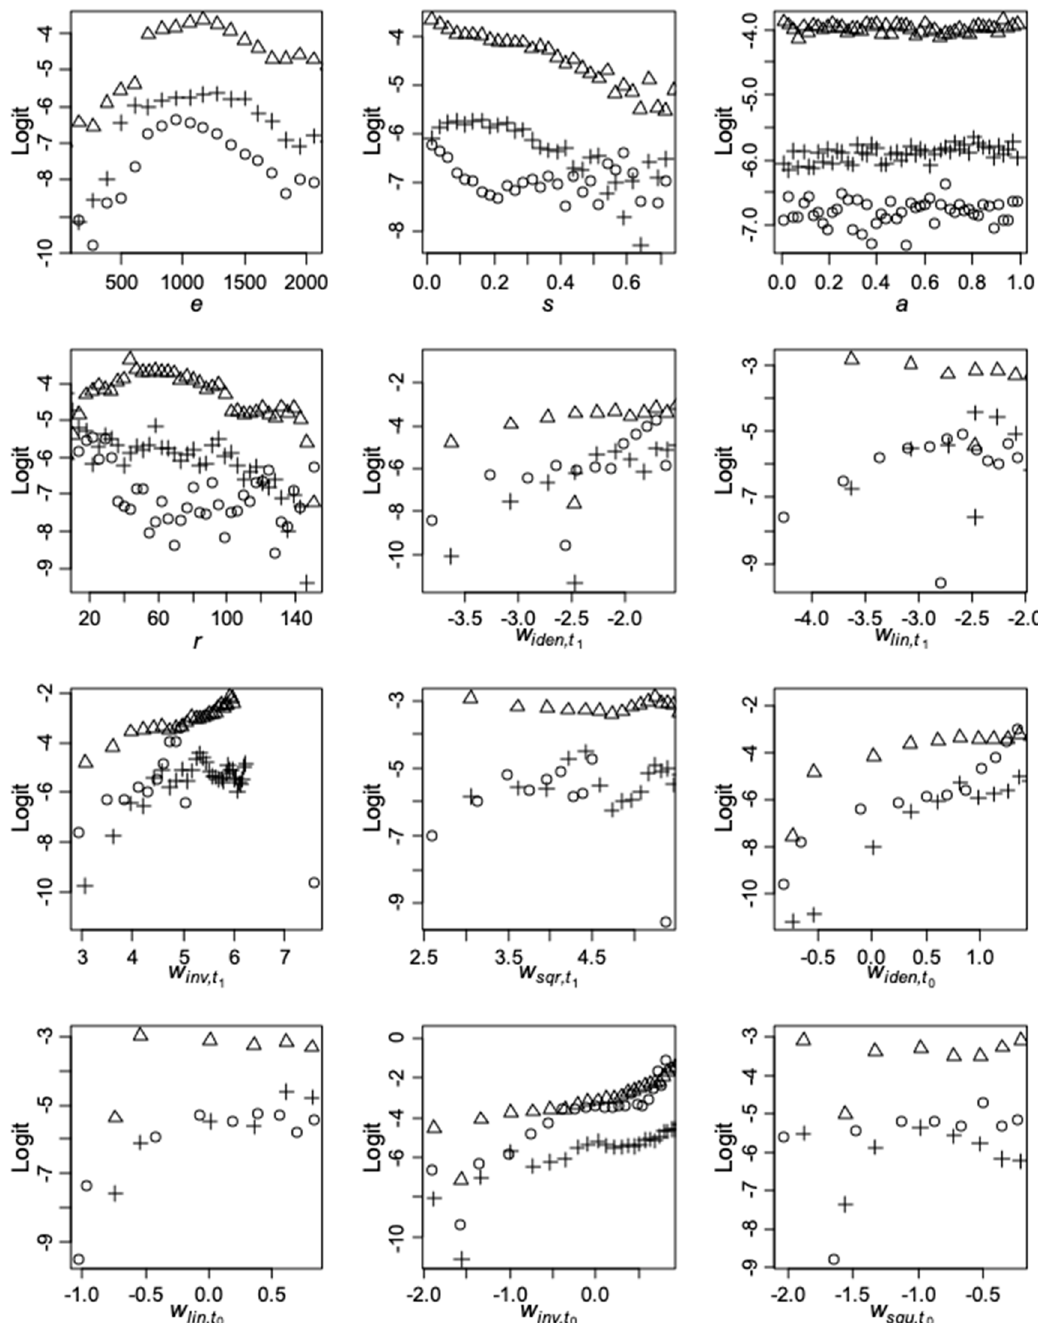
Figure A5. Plots of average mortality vs. predictors in three transition periods: 2001–2002 (circles), 2007–2008 (triangles), and 2013–2014 (plus signs).